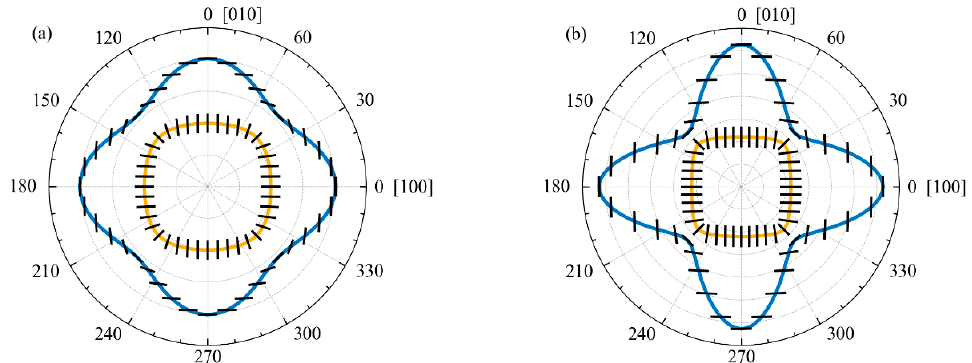
Figure 7. Distribution of the averaged polarization vector of acoustic modes in a phononic crystal with a normalized hole diameter: ( a ) d/a = 0.6 and ( b ) d/a = 0.8.